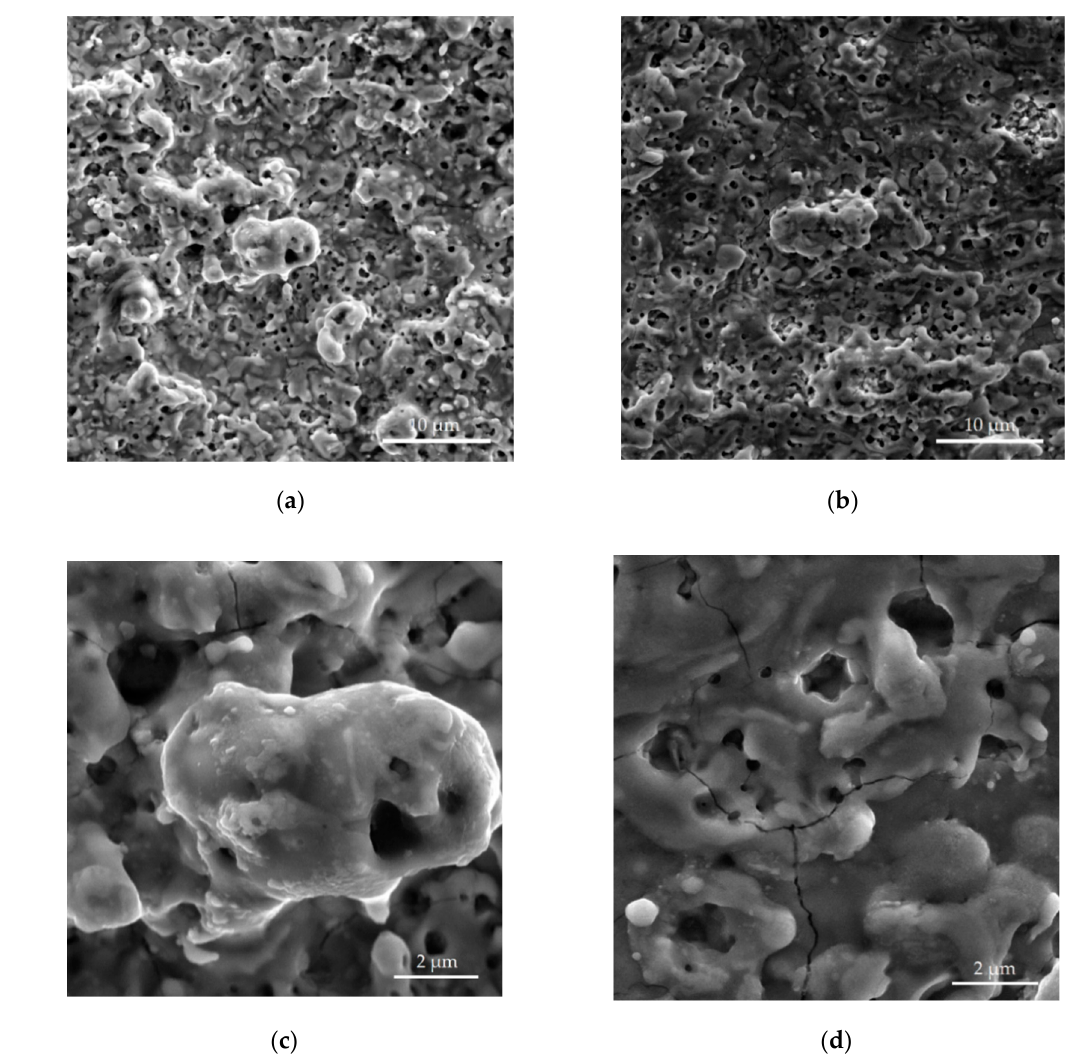
Figure 5. Roughness of the Al 2 O 3 + 30%TiC nanocomposite samples after machining: ( a ) oil; ( b ) water.